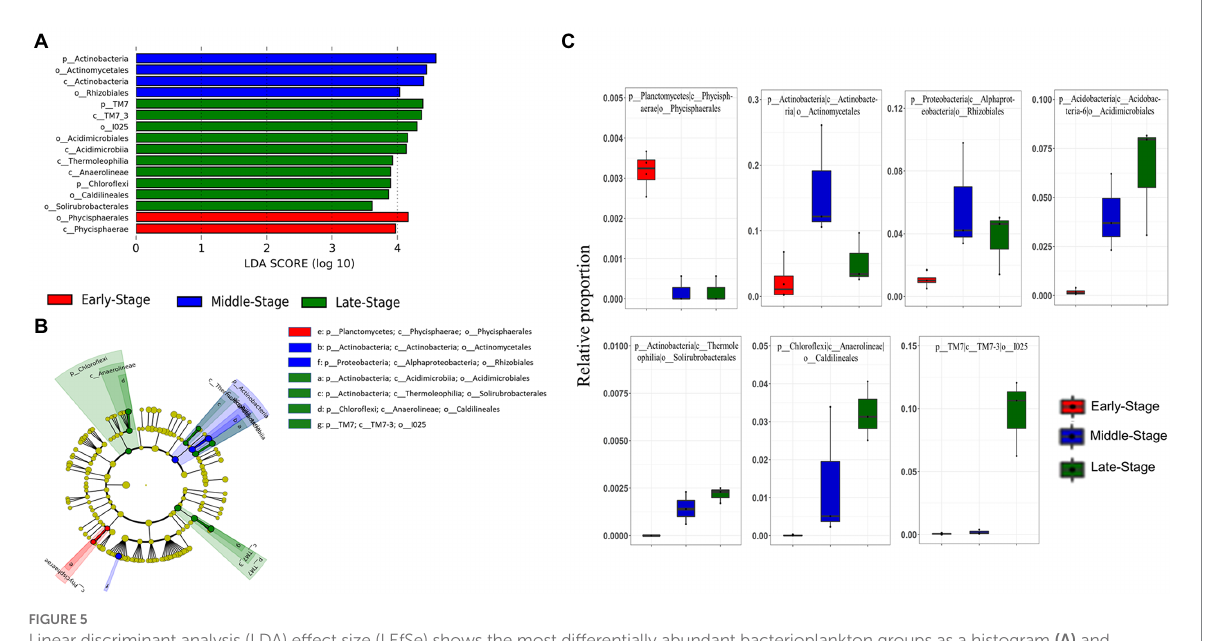
FIGURE 5 Linear discriminant analysis (LDA) effect size (LEfSe) shows the most differentially abundant bacterioplankton groups as a histogram (A) and cladogram (B) in rearing water of a BFT-based aquaculture system during various culture stages. The relative proportion of the identified bacterioplankton taxa through LEfSe are represented as boxplots (C) . Bacterioplankton groups that possess an LDA threshold > 3 are only represented. In the cladogram, each ring indicates a taxonomic level (e.g., center to outermost as phylum, class, order), while each circle indicates a bacterioplankton group. The taxonomic groups highlighted with different colors signify their enrichment in a particular culture